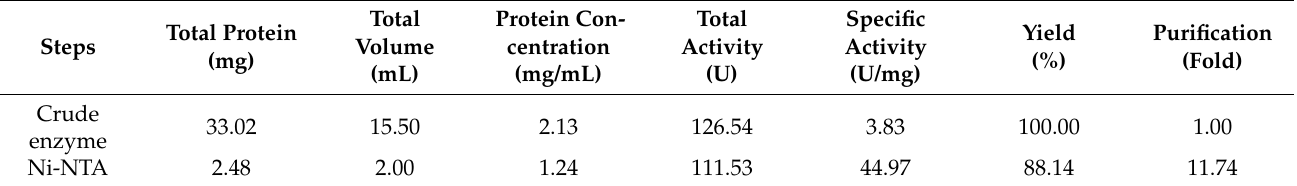
Table 3. Purification of recombinant